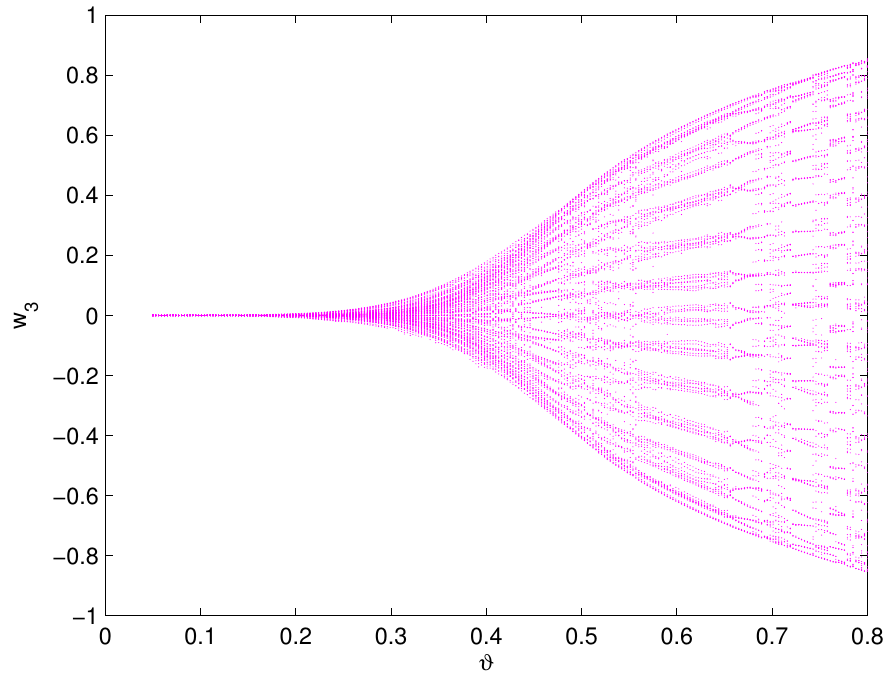
Figure 12. Bifurcation graph of system (72): the delay ϑ versus the variable w 3 . The bifurcation number is